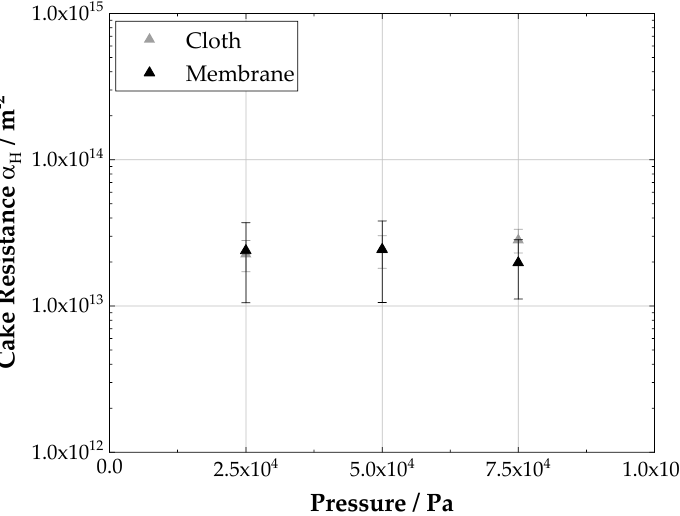
Figure 8. Height specific filter cake resistances of rod-like lysozyme crystals measured with the pressure nutsche using a membrane and a cloth as filter medium.